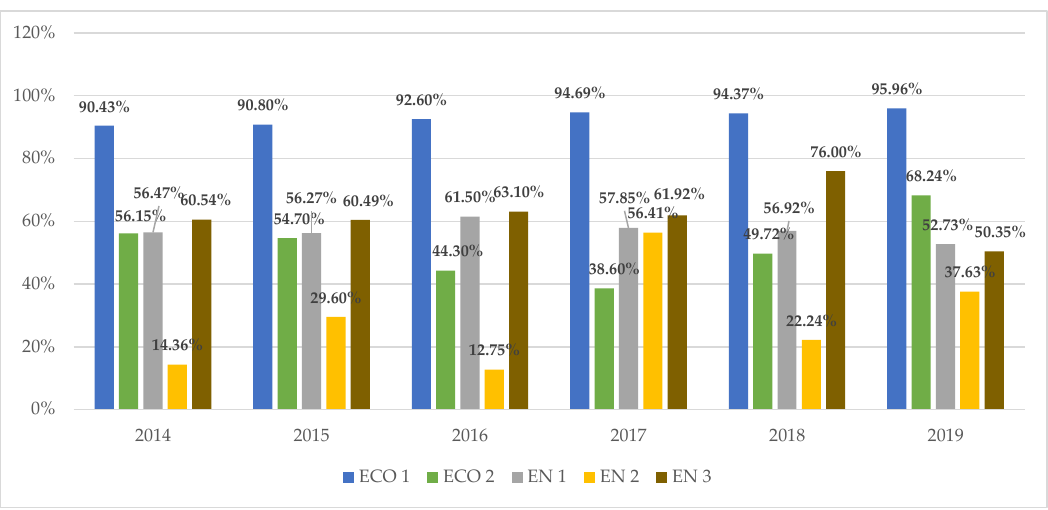
Figure 1. Share of commercialization revenue in total revenue of surveyed research institutes from 2014 to 2019. Source: own compilation based on the financial statements.